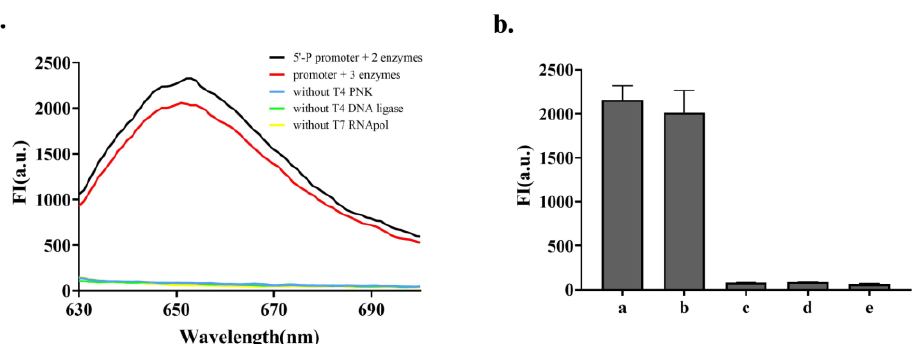
Figure 1. Fluorescence spectrum of the sensing system containing 200 nM promoter probes, aptamer probes, and help probes in the presence of different concentrations of T4 PNK (blue: 0 and red: 5 U/mL), 20 U/mL T4 DNA ligase, and 100 U/mL T7 RNA polymerase. The black, green, and yellow curves are for the control experiment using 200 nM purchased phosphorylated promoter probes instead of unphosphorylated promoter probes in the absence of T4 PNK, T4 DNA ligase, T7 RNA polymerase. Histograms a, b, c, d, e in ( b ) correspond to black, red, blue, green and yellow curves in ( a ) respectively. The error bars represent the standard deviation (SD) across three repetitive experiments over the blank response.